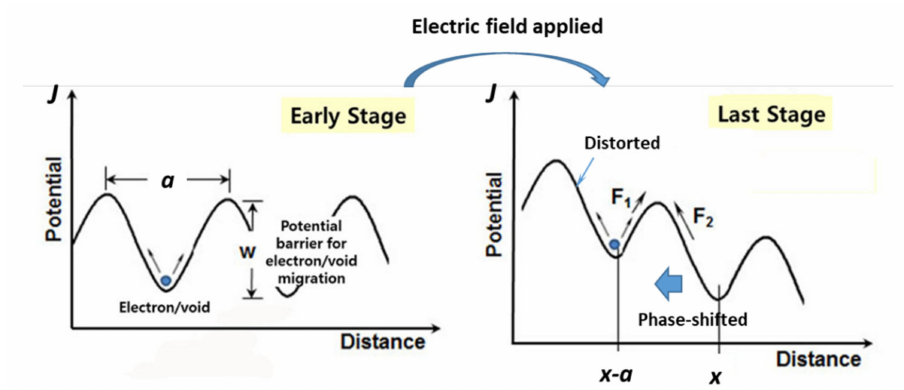
Figure 6. Potential exchange in material such as silicon as electrical field is